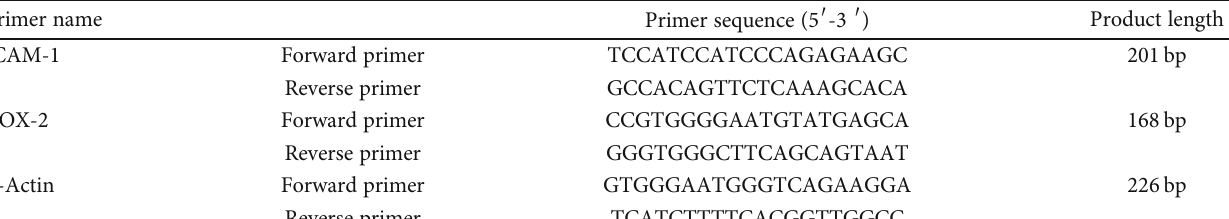
Table 1: Primer sequences and length of the ampli fi ed product.